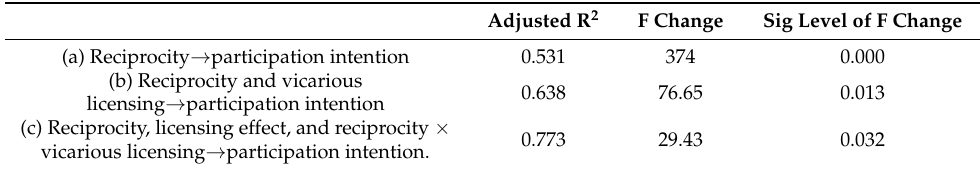
Table 9. The results of moderating effect of vicarious licensing on participation